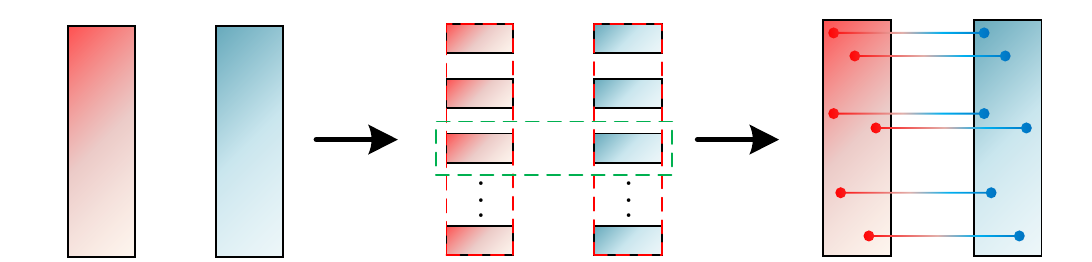
Figure 6. Equal division and parallel registration.